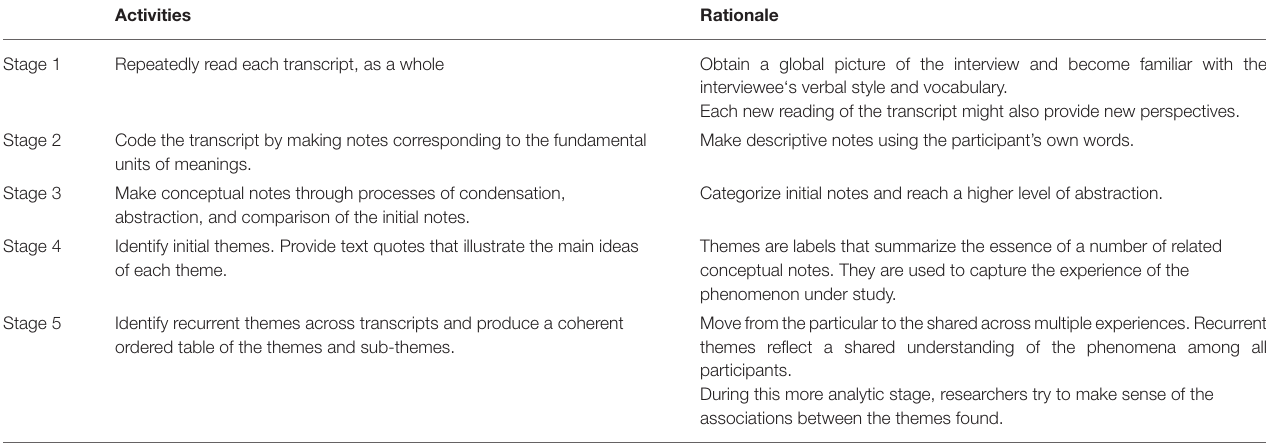
TABLE 2 | The five steps of analysis data. Activities Rationale Stage